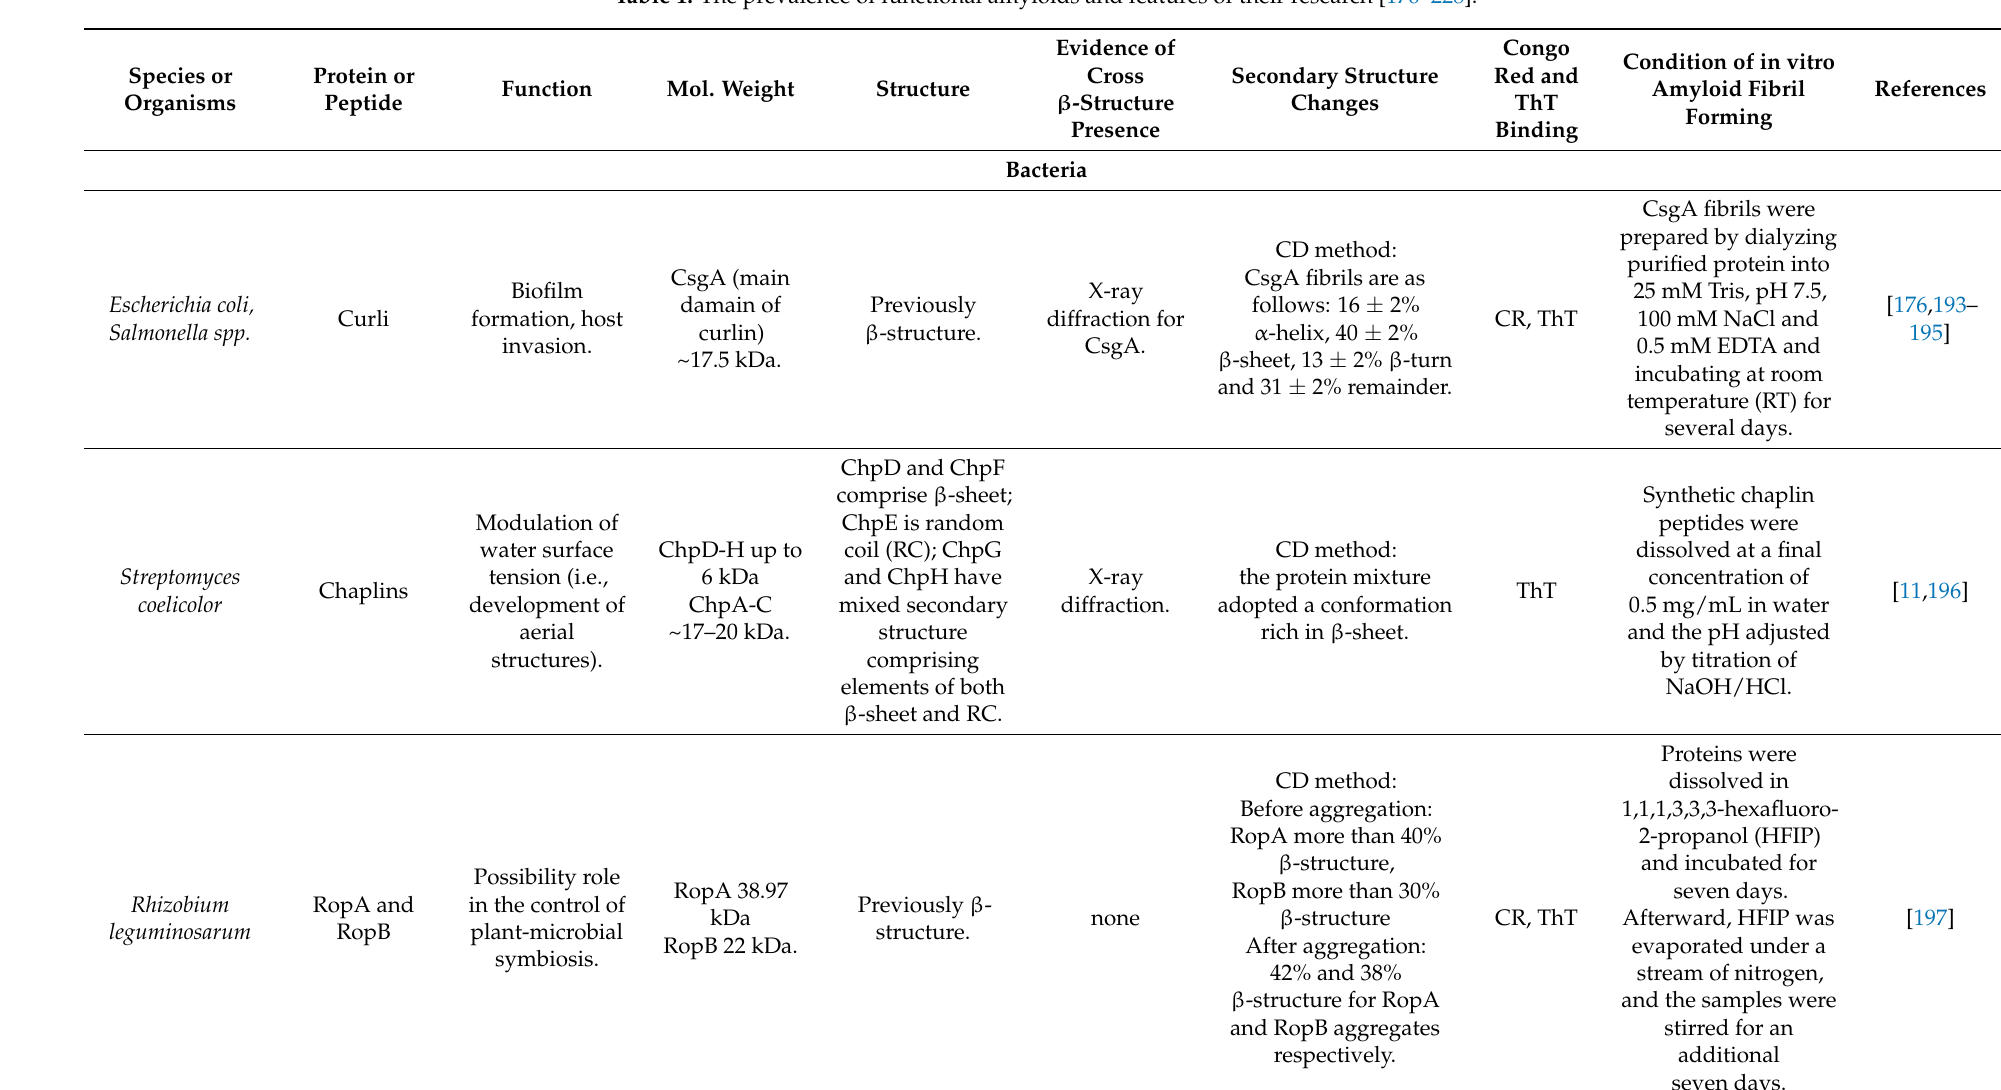
Table 1. The prevalence of functional amyloids and features of their research